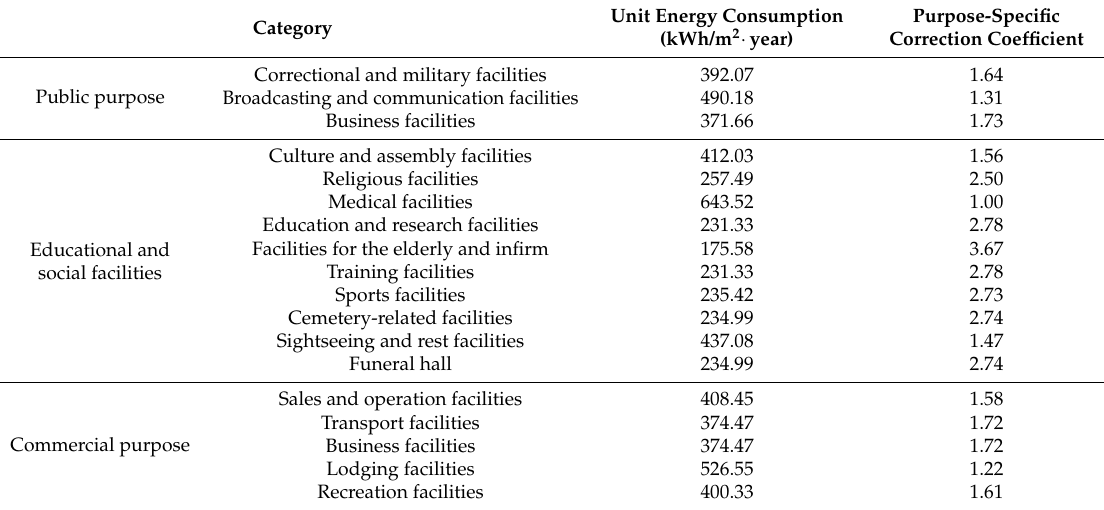
Table 2. Building purpose-specific unit energy consumption and correction coefficients.